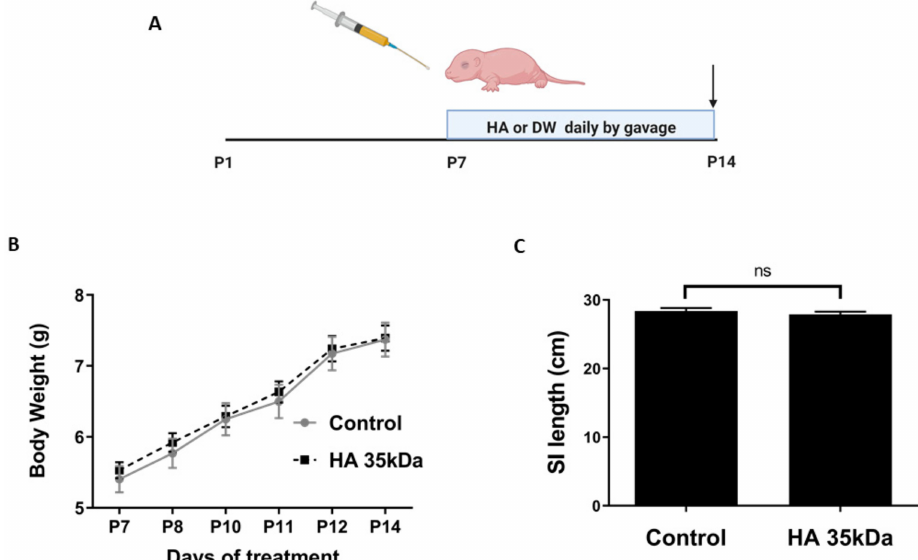
Figure 1. Oral HA 35 KDa supplementation for 7 days does not affect pup body weight or small intestinal lengthening. ( A ) Mouse pups were gavaged either HA 35 KDa (30 mg/kg) or an equal volume of sterile water daily from P7–P14, with arrow depicting the end of treatment. ( B ) Pups from both groups ( n > 10 mice per group) were weighed daily during supplementation. HA 35 KDa did not affect the weight gain compared to controls ( p ≥ 0.574). ( C ) SI length at the time of euthanasia (P14) did not differ between the groups ( p = 0.394). Data presented as mean ± SEM. HA: